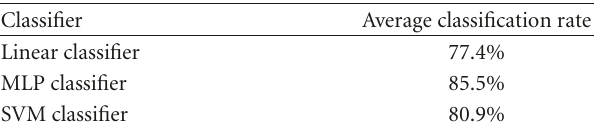
Table 4: Classification rates for 30 ◦ data, using features trained with 0 ◦ data.